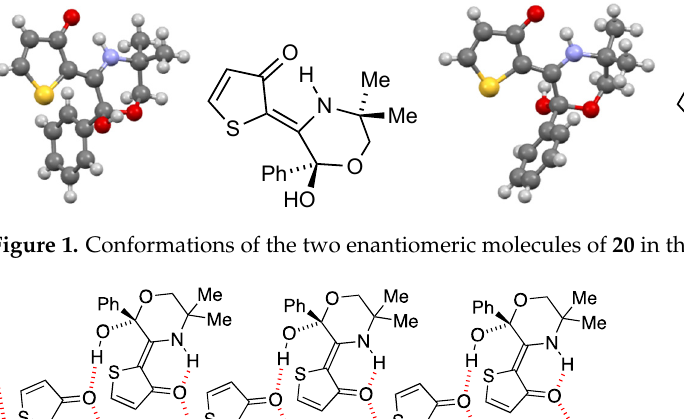
Figure 1. Conformations of the two enantiomeric molecules of 20 in the crystal.